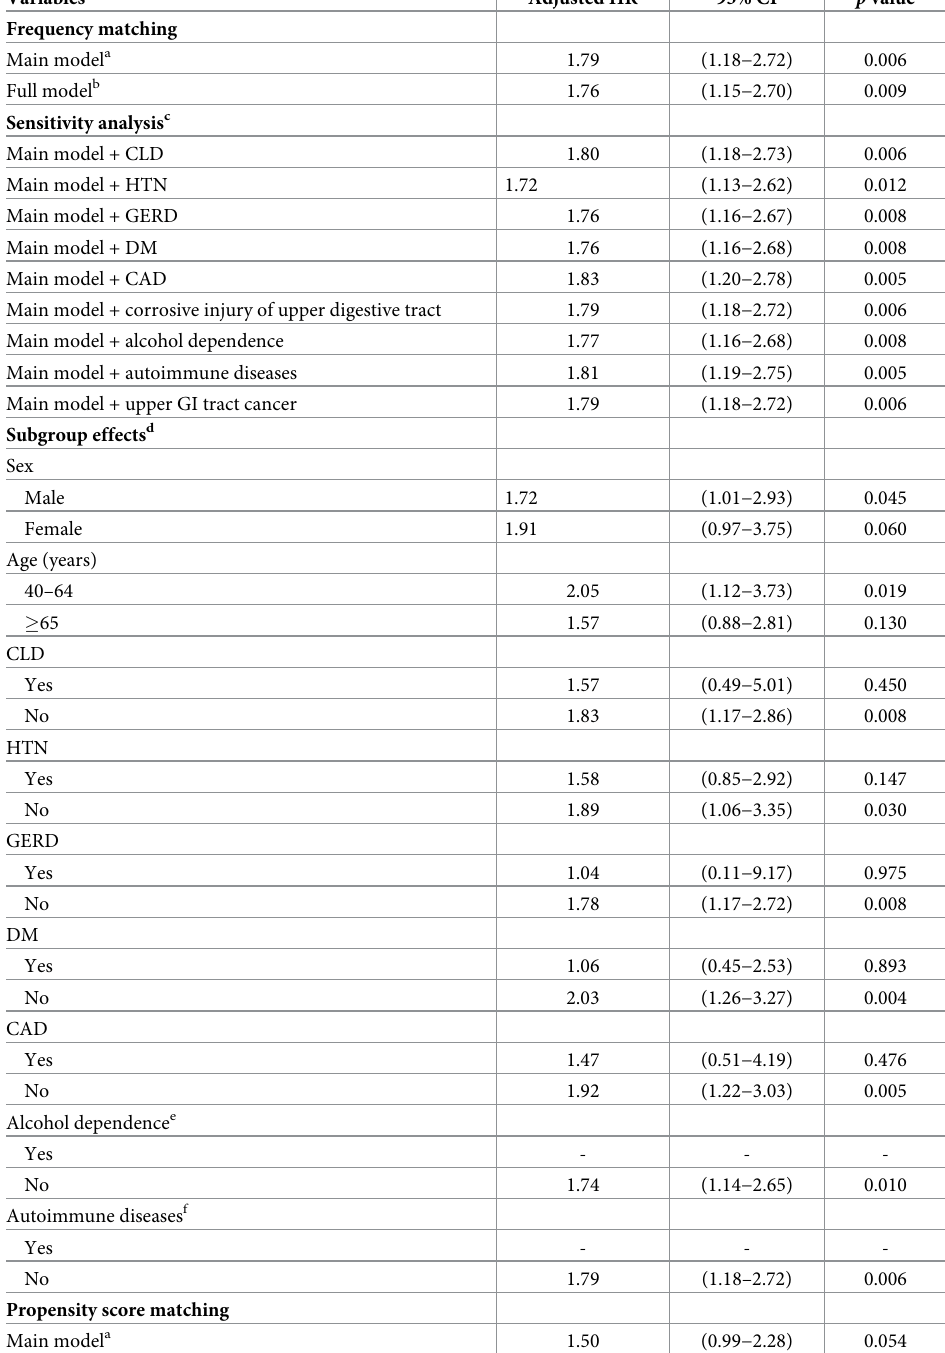
Table 3. Multivariable Cox proportional hazard model of the association between epiglottitis and potential risk